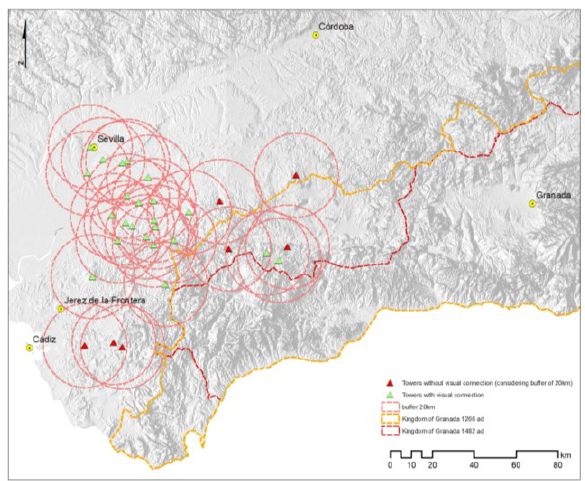
Figure 9. Thematic map in which the towers that have or have not visual connection are noted in the simulation; this considers the 20km buffer.